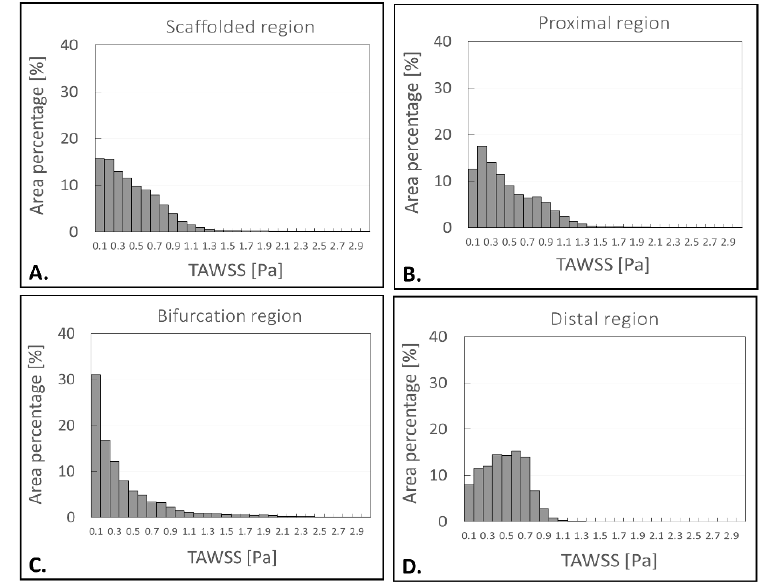
Figure 6. Histograms of the scaffolded surface percentage area under intervals of time-averaged wall shear stress (TAWSS) from 0 Pa and 3 Pa. ( A ): Scaffolded region of the main branch; ( B ): Proximal region of the scaffolded main branch; ( C ): Bifurcation region of the scaffolded main branch; ( D ): Distal region of the scaffolded main branch.